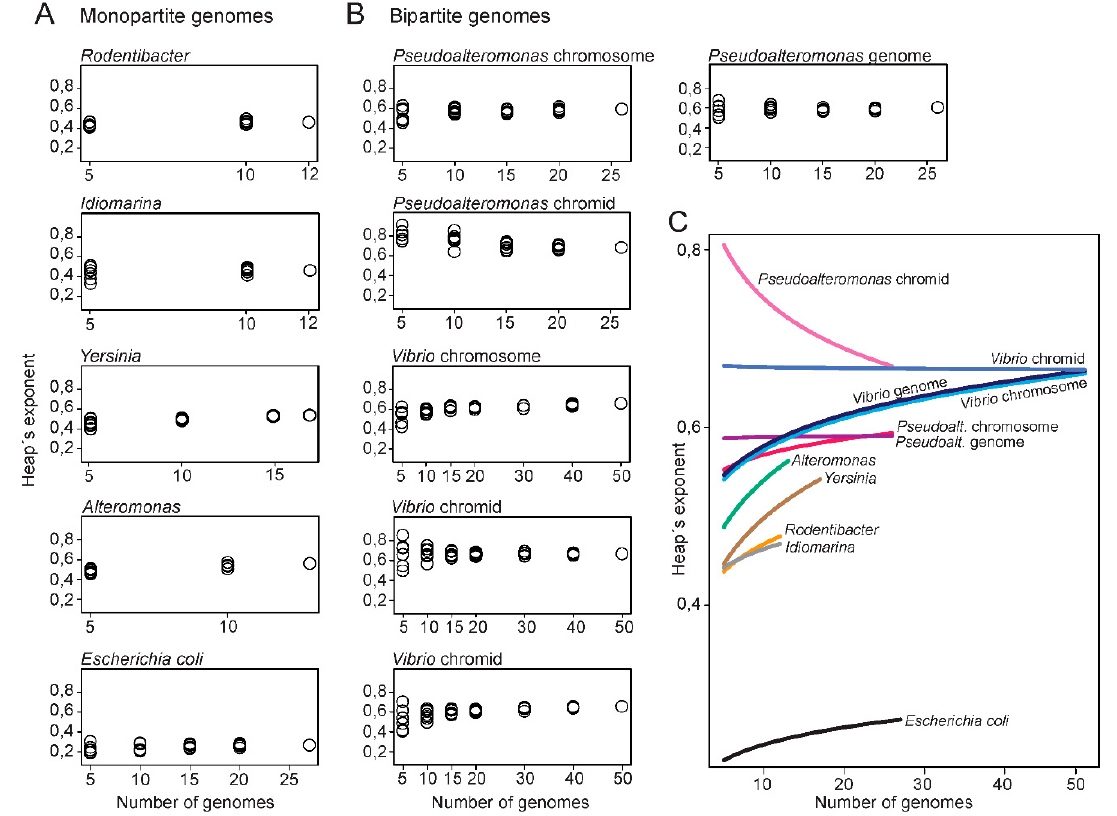
Figure 4. Plots of Heaps’ exponents against the number of genomes. The analysis was carried out for datasets with monopartite ( A ) or ( B ) bipartite genomes. Each of the Heaps’ exponents are made from the median number of pangenome sizes from 100 randomly generated strain orders. ( C ) Rarefaction curves of Heaps’ exponents plotted against number of genomes. The curves can be regarded as a summary and of the results from ( A , B ) through curve fitting of the Heaps’